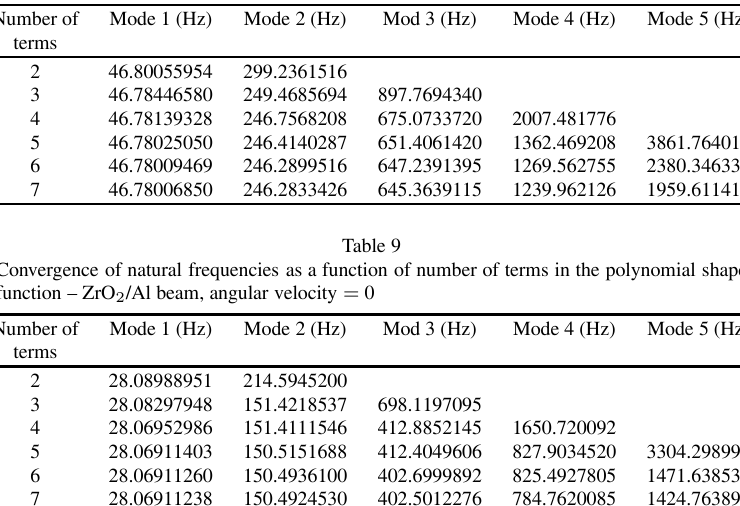
Table 8 Convergence of natural frequencies as a function of number of terms in the polynomial shape